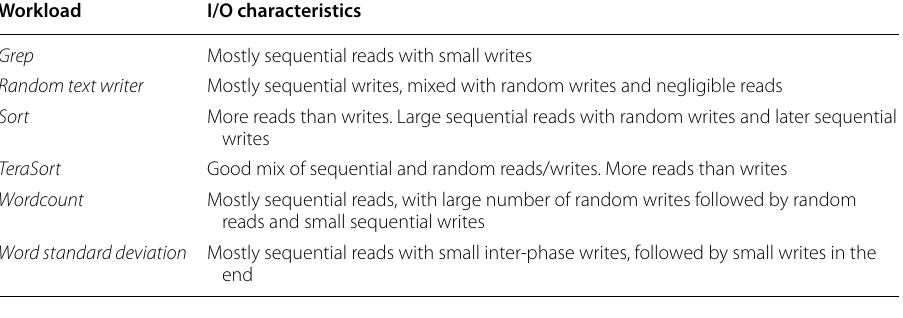
Table 2 Cloud emulating Hadoop benchmarks: I/O characteristics